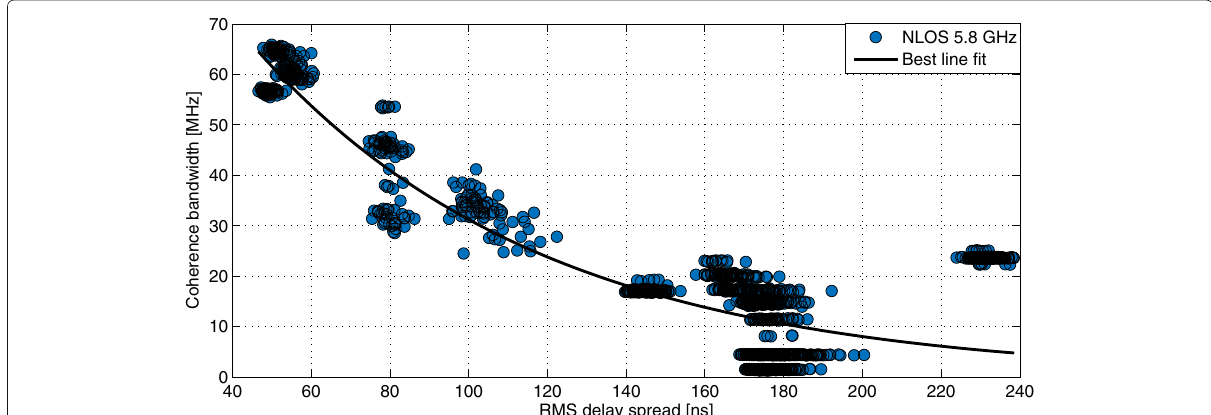
Fig. 13 Coherence bandwidth versus root mean square delay spread for 5.8GHz. Scatter plot of the coherence bandwidth B c ,0.5 against the root mean square delay spread in the case of a transmitted signal with 5.8GHz center frequency in non-line of sight